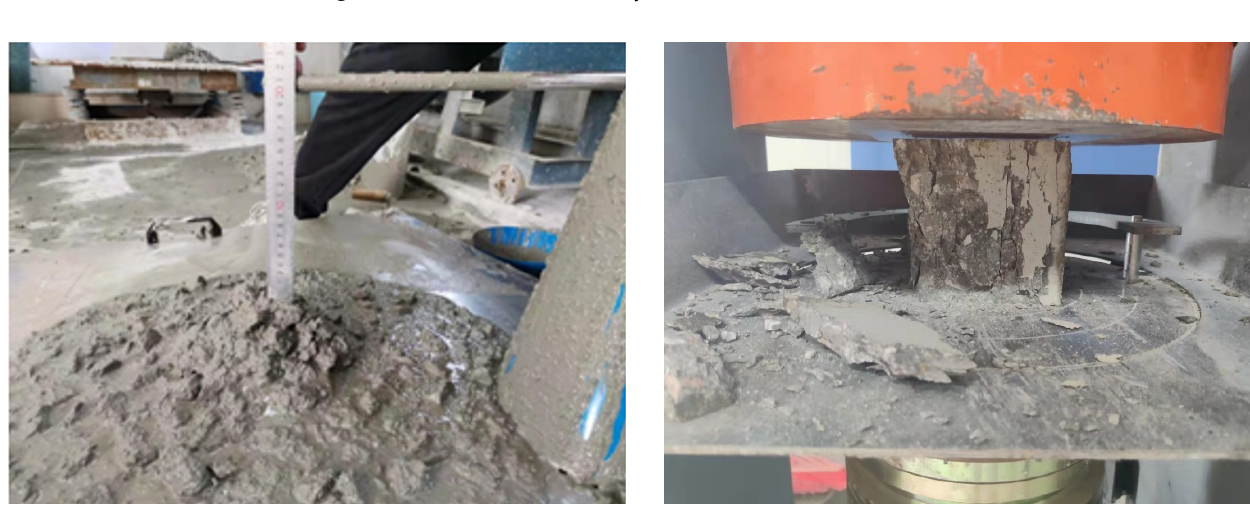
Figure 2. Flow chart of this study.